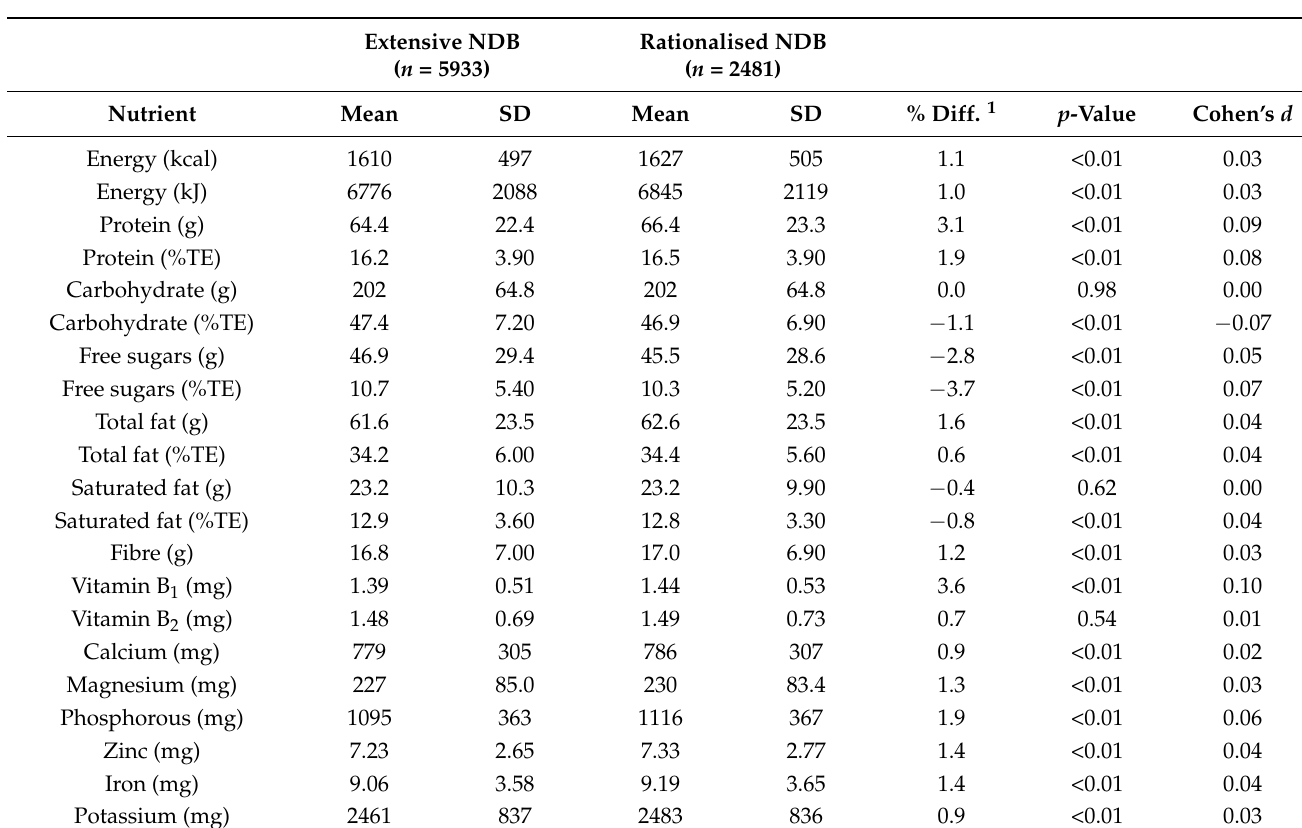
Table 2. Differences in the mean daily intake of energy, nutrients, and selected foods from food sources (excluding nutritional supplements) in NDNS year 2017 respondents ( n = 1211) aged 1.5–93